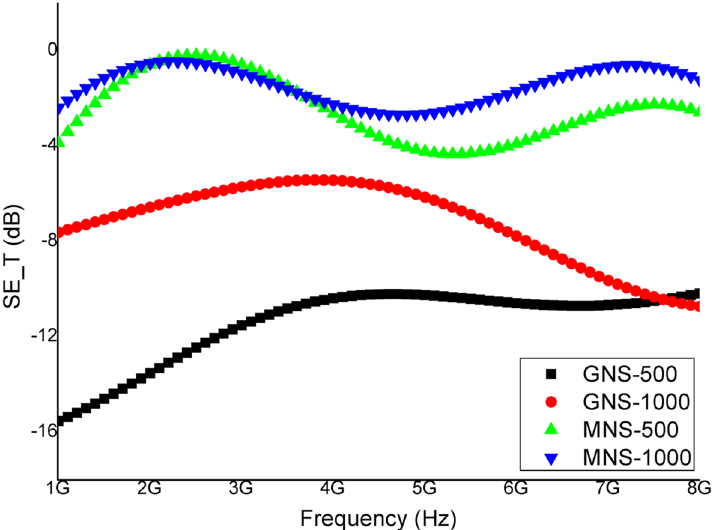
Figure 4. EMI shielding effectiveness analysis (experimental) of GNS and MNS both for 1000 rpm and 500 rpm as a function of frequency (1–8 GHz).